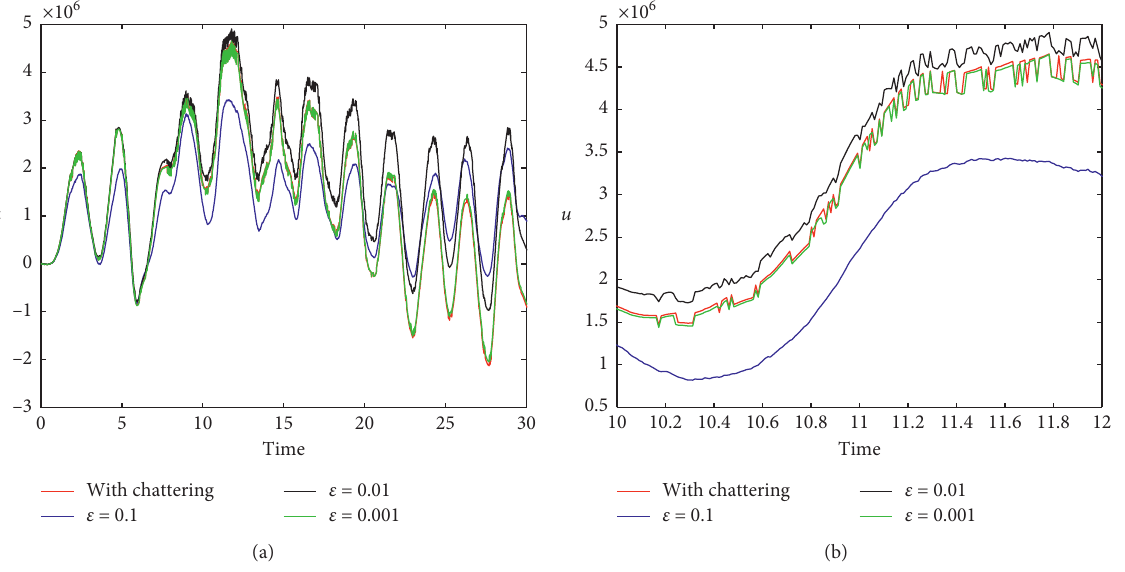
Figure 5: (a) The variations of force u corresponding to Figure 4 for different ε . (b) Detailed view of Figure